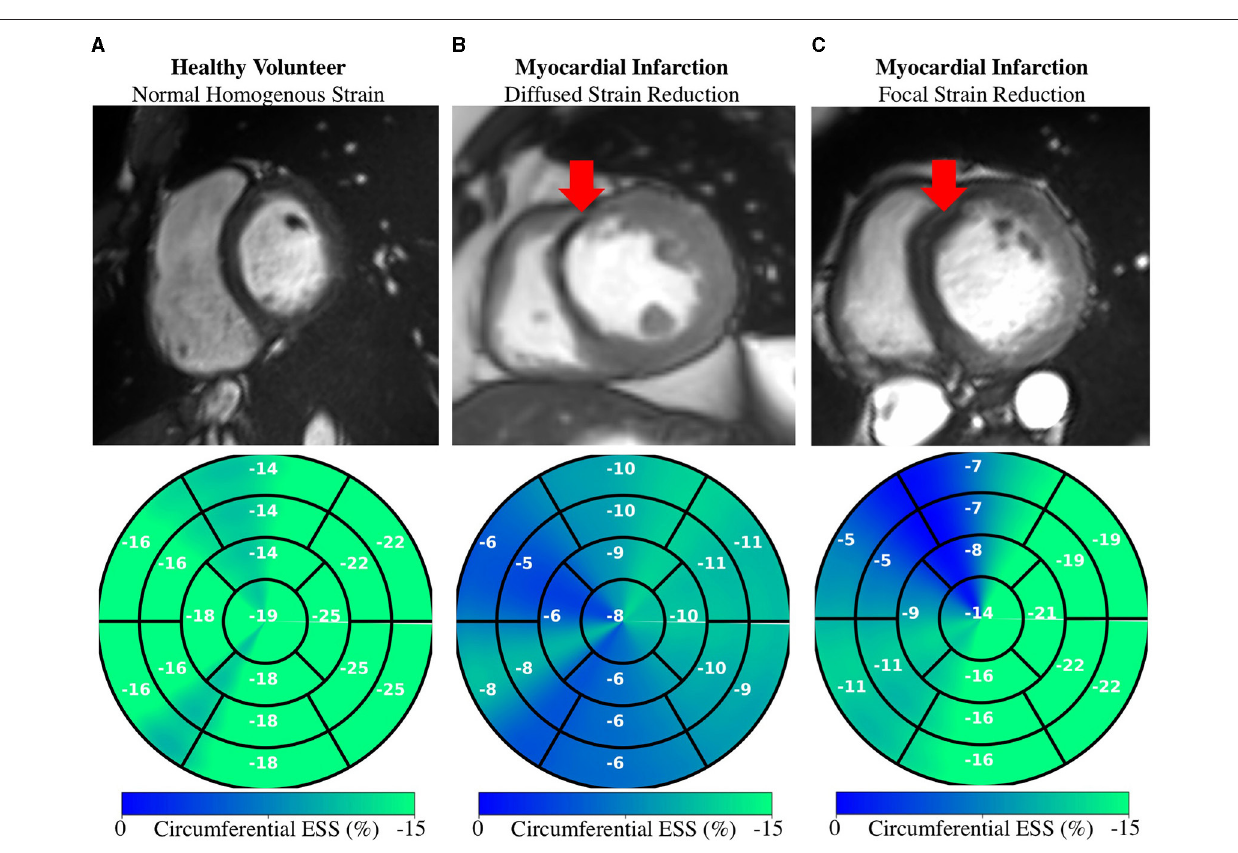
FIGURE 8 | Regional Strain: Diffused vs. focal abnormalities. Anatomical (top) and regional (bottom) circumferential end-systolic strain (ESS) for healthy and MI subjects. (A) Healthy strain is homogenously distributed. (B) MI subject shows diffused strain reduction with an MI in the anteroseptal region. (C) Different MI subject shows a focal decrease in the anteroseptal region co-localized with the infarcted region (red arrows). MI, myocardial infarction. Volumetric